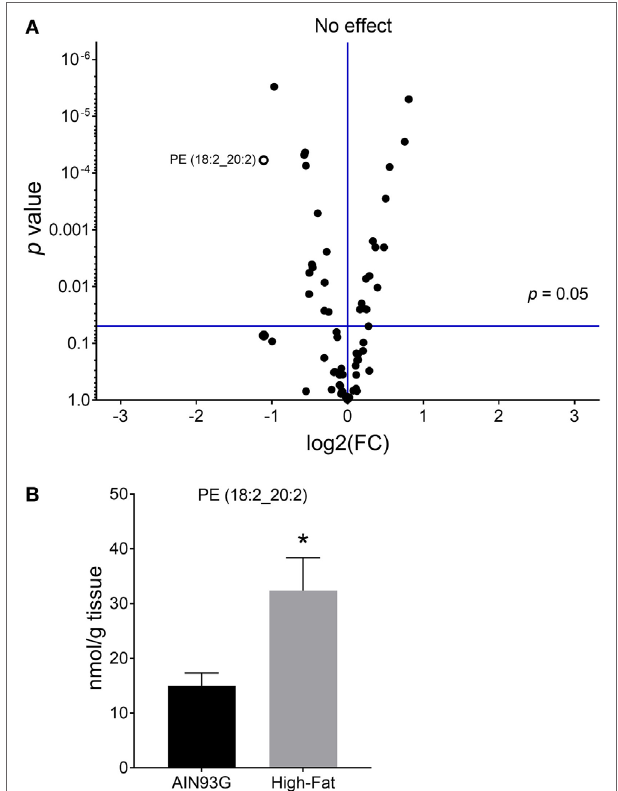
FigUre 3 | Changes in phosphatidylcholine (PC) regioisomers in primary tumors of Lewis lung carcinoma in response to consumption of high-fat diet. Data are presented as the % of sn1 isomer for each lipid ( n = 6 per group). * p ≤ 0.05 for each